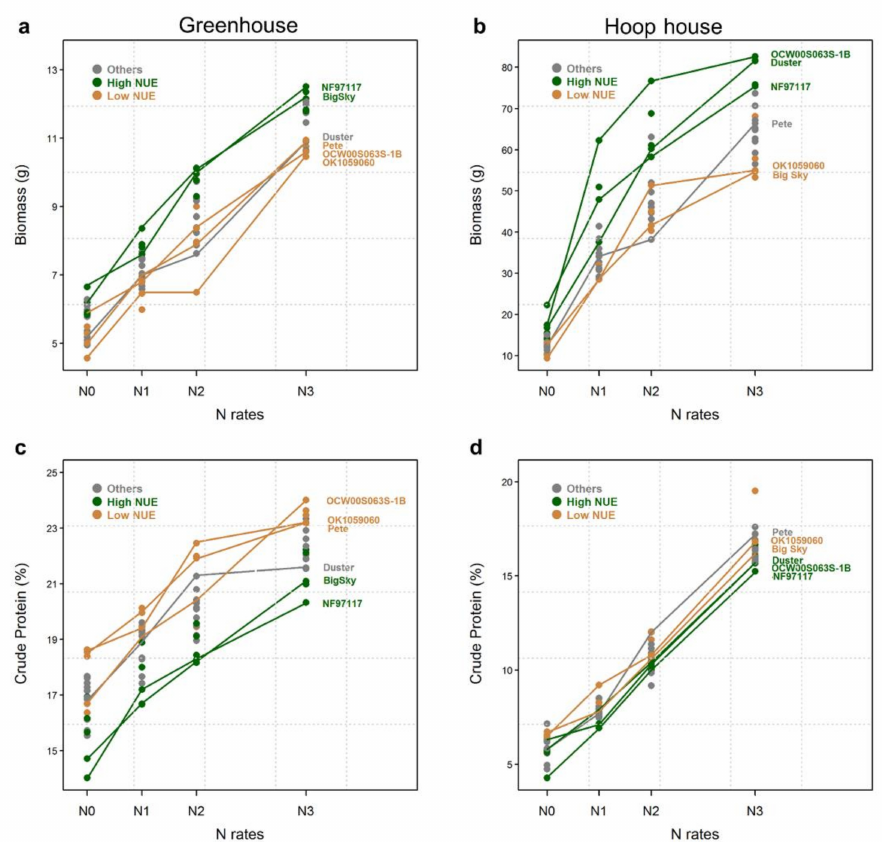
Figure 1. Biomass ( a , b ) and crude protein ( c , d ) of 20 winter wheat cultivars / lines evaluated in greenhouse (left panel) and hoop house (right panel) under four di ff erent N rates. Green and orange points correspond to the lines with the highest and lowest NUEs, respectively, in each environment, which were also evaluated for root traits. Grey points are all the other